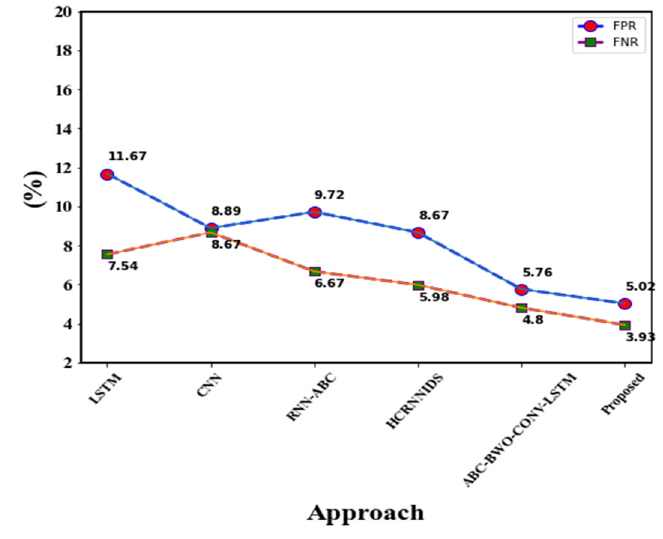
Figure 14. FPR and FNR comparison.